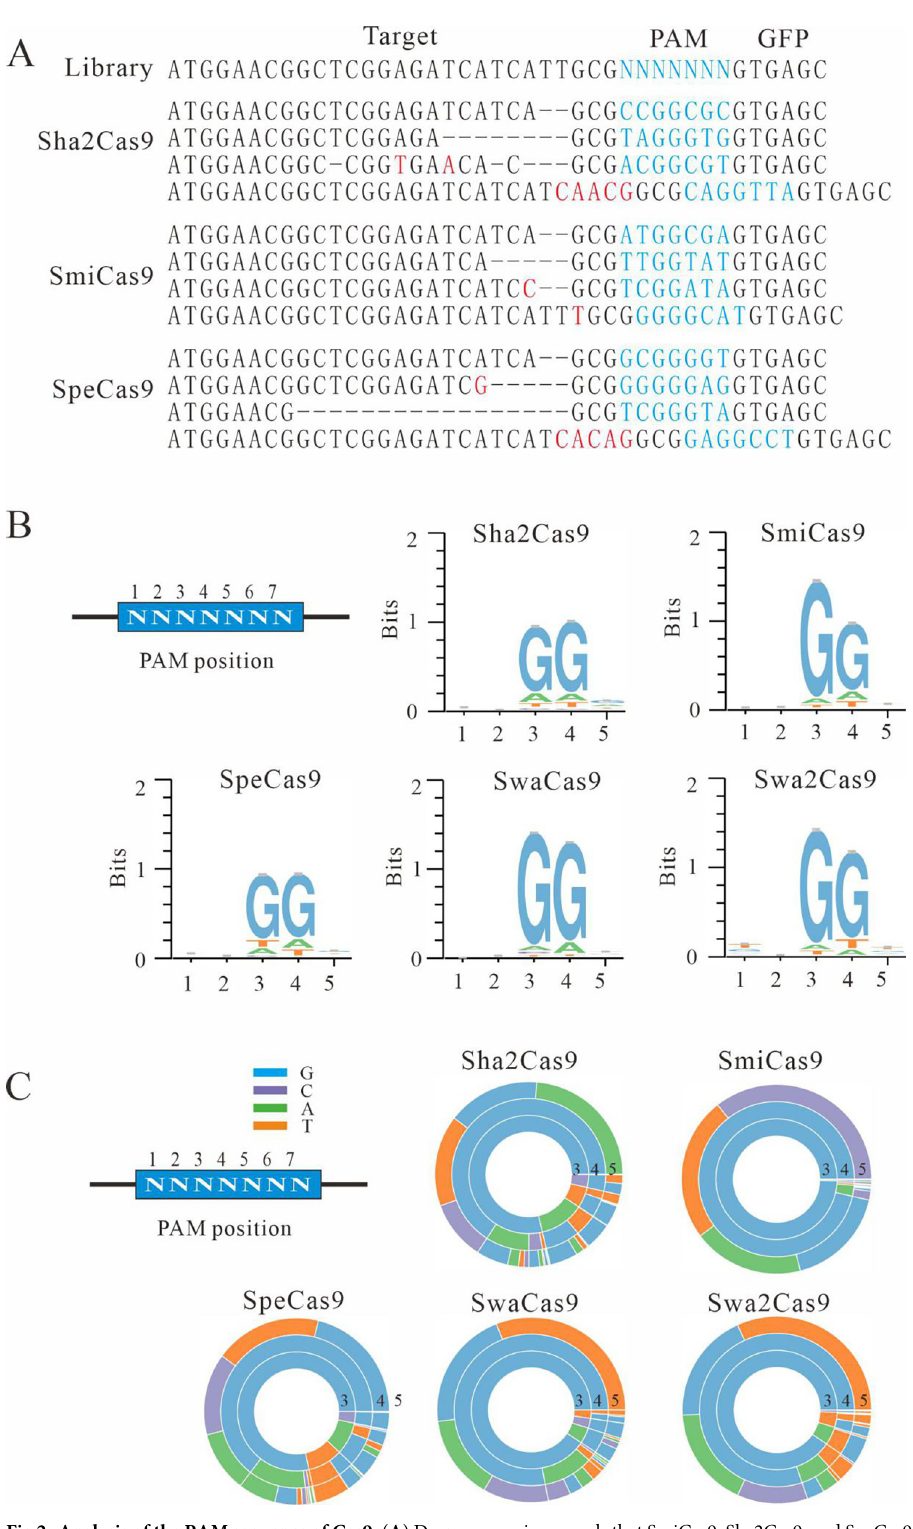
Fig 2. Analysis of the PAM sequence of Cas9. ( A ) Deep sequencing reveals that SmiCas9, Sha2Cas9, and SpeCas9 generated indels on the targets. ( B ) WebLogos were generated based on the deep sequencing data. ( C ) PAM wheels were generated based on the deep sequencing